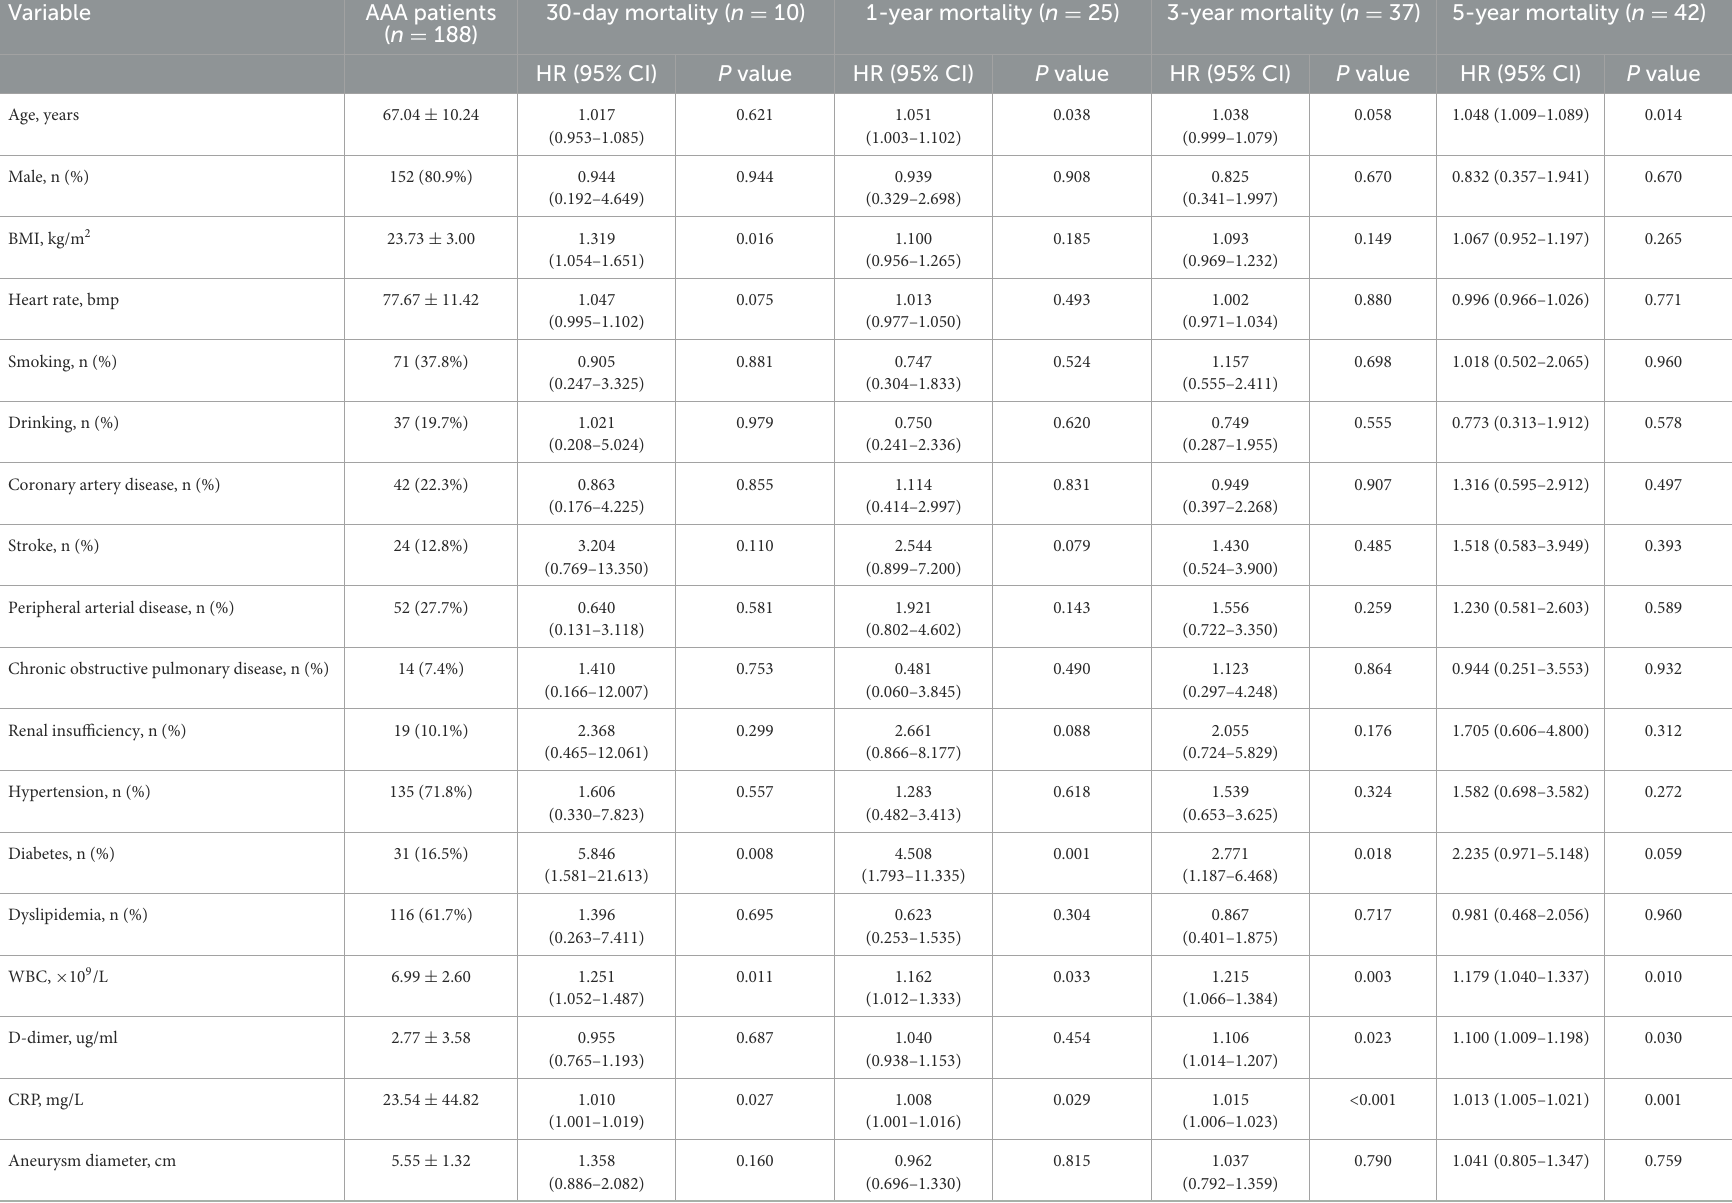
TABLE 1 Univariate Cox regression analyses of factors associated with mortality following EVAR for AAA during